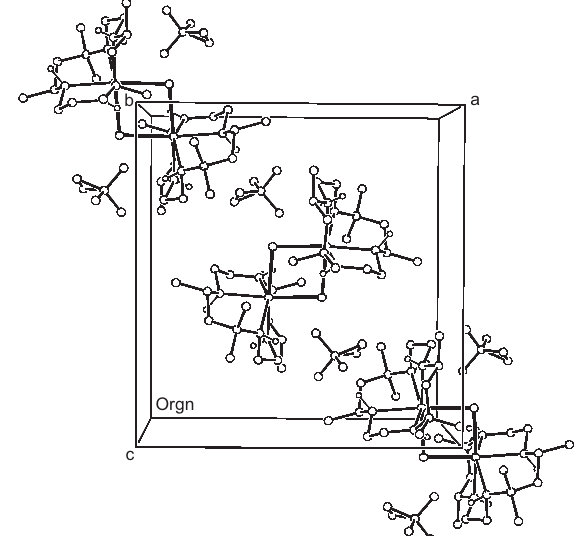
Figure 2 Crystal packing diagram of [Cd(L)( µ -Cl)] The hydrogen atoms are omitted for clarity.